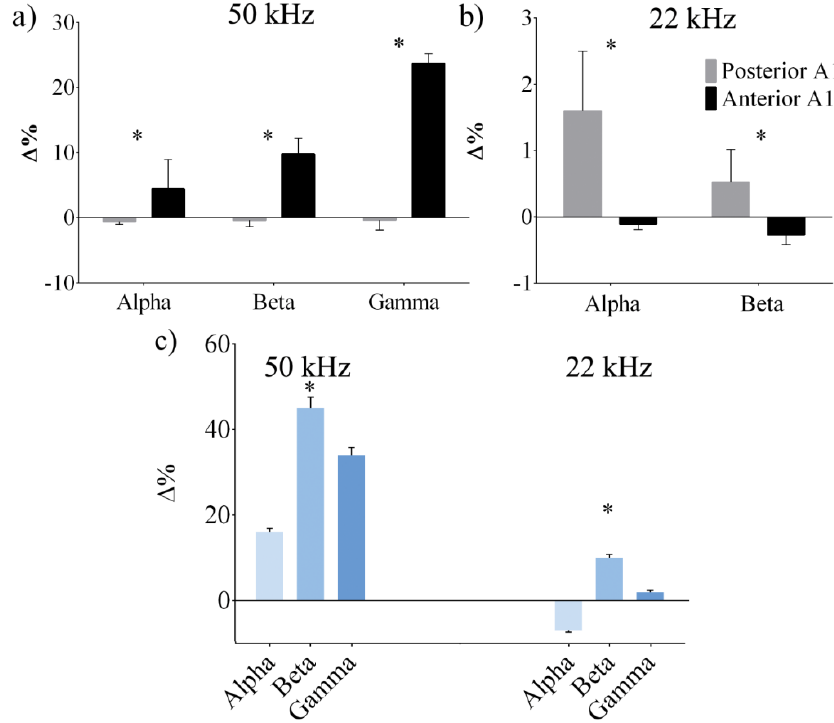
Figure 12. ( a ) Power spectral density (PSD) variations during electrical stimulation (AET-50 kHz) compared with the background. Alpha, beta, and gamma waves were activated in the anterior area that represents the tonotopical receptive field for ultrasound at 50 kHz in A1. The opposite zone was inhibited. ( b ) The graph shows the comparison of PSD versus background during stimulation with AET-22 kHz echoes properly transduced into electrical signals in the A1. The posterior area was activated in the alpha and beta content. ( c ) PSD variations during acoustical stimulation at 50 and 22 kHz compared with the background recorded in the frontal cortex. * p < 0.05.